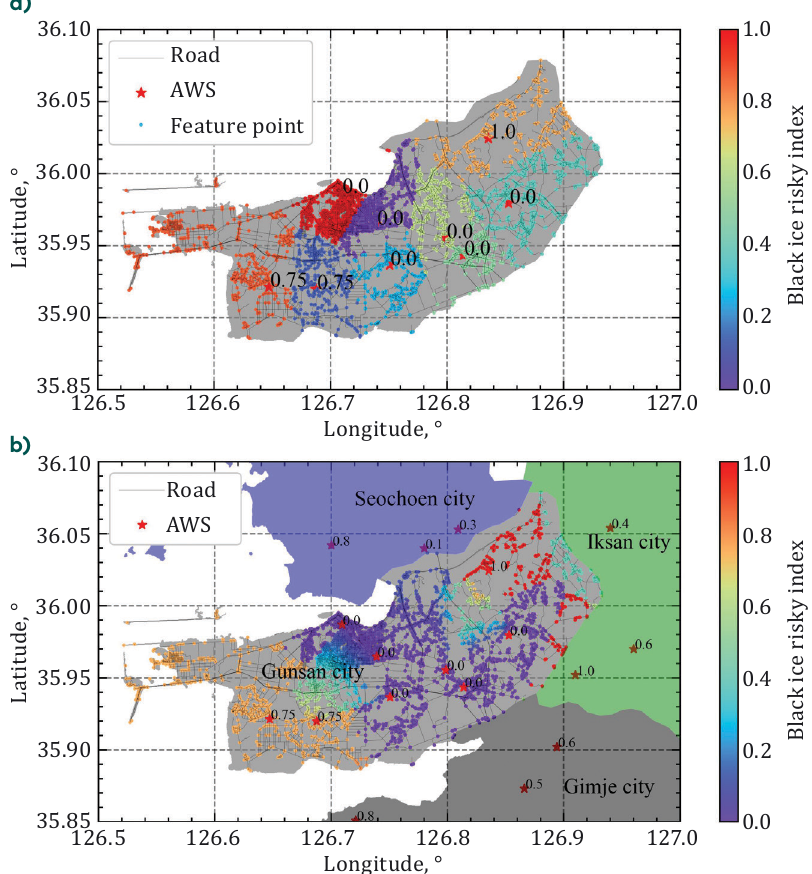
Figure 8. Nearest neighbour and triangle interpolation algorithm Longitude,